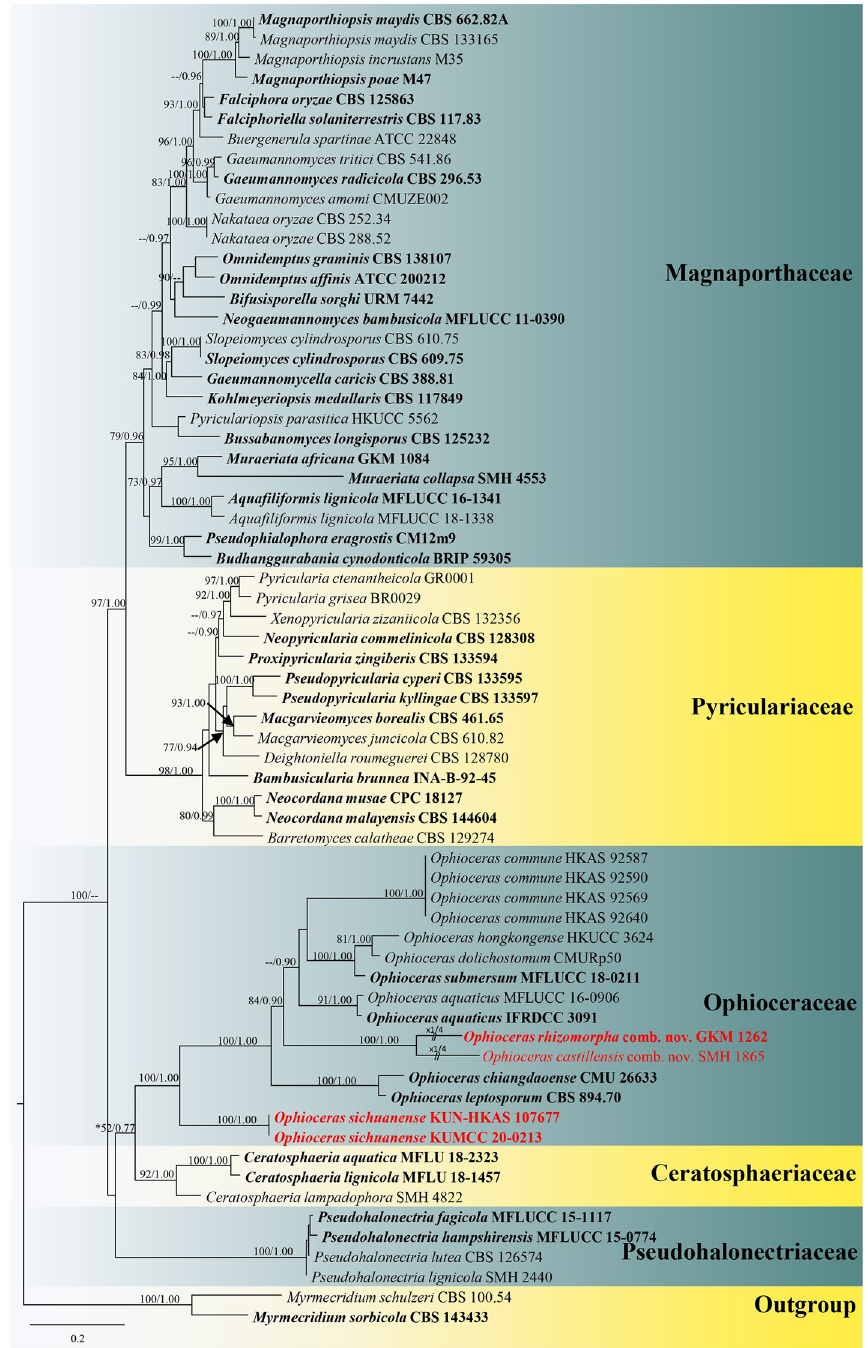
Fig 1. Maximum likelihood tree based on a combined LSU, RPB1 and ITS sequence matrix for taxa in Magnaporthales. Bootstrap support values for ML equal to or higher than 70% and the Bayesian posterior probabilities equal to or higher than 0.90 PP are defined above the nodes as ML/PP. Ex-type strains are in black bold, and new species and new combinations are indicated in red bold.